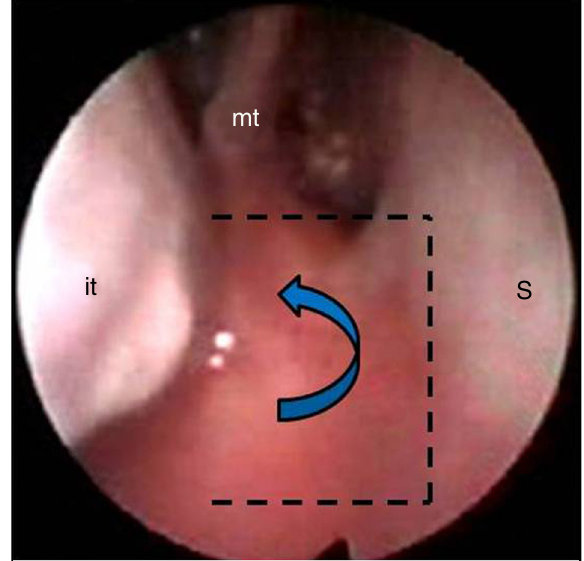
Endoscopic view: intranasal incisions on the atretic plate, fashioning a lateral flap (dotted lines). it, inferior turbinate; mt, middle turbinate; S,